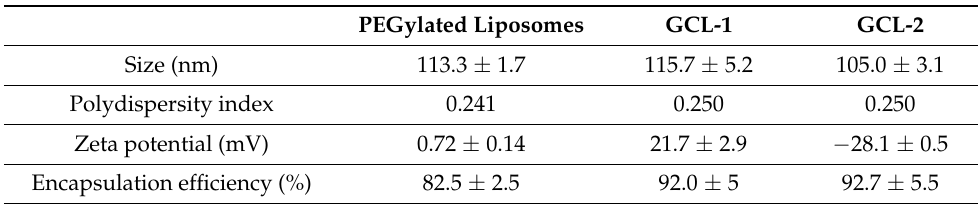
Table 2. Main characteristics of the liposomes. The gelatin concentration of GCL-1 and GCL-2 was 250 µ